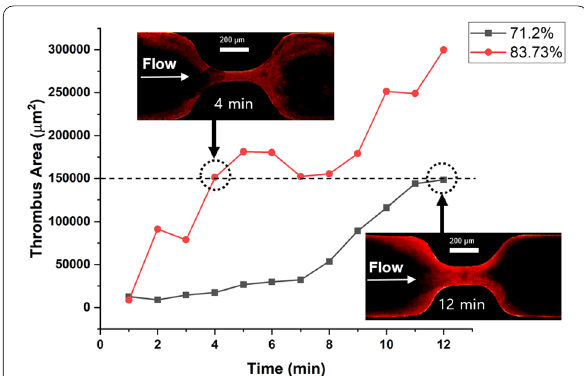
Fig. 4 Comparison of thrombus area over time in thrombus chip with stenosis of 71.2% and 83.73%